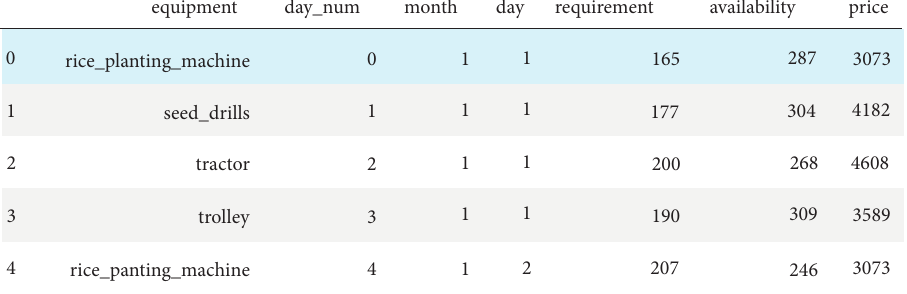
Figure 6: Mean price per day of the